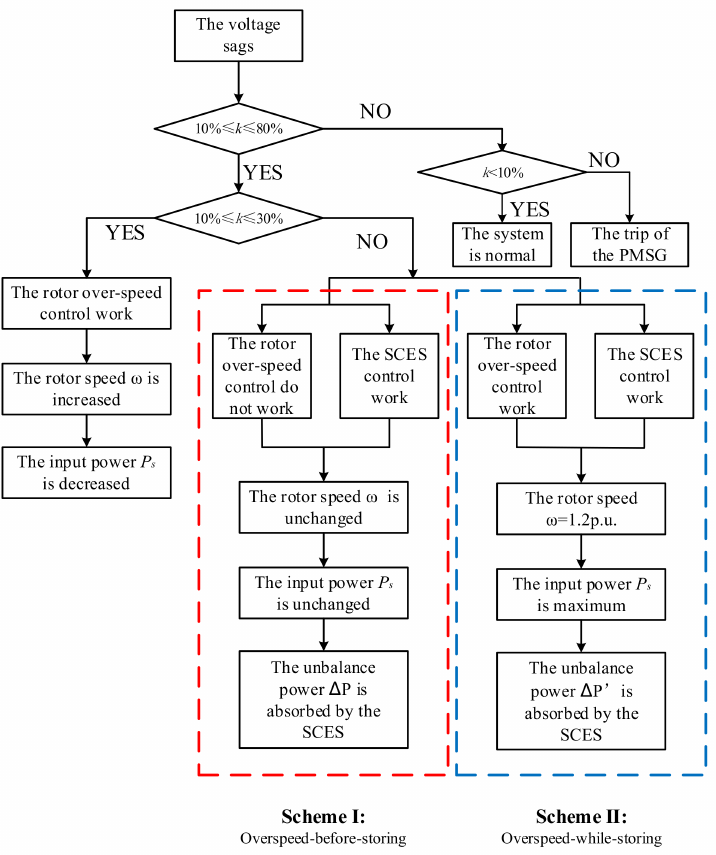
Figure 8. The flow chart of the two coordination control